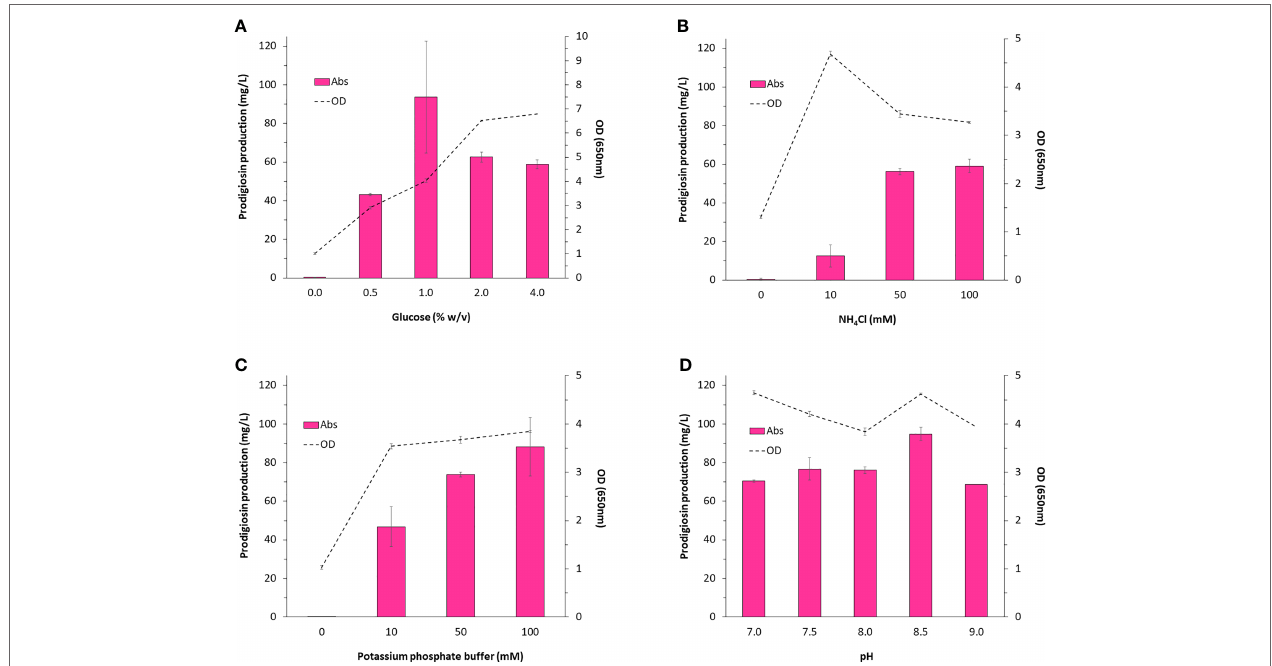
FIGURE 2 | Medium components impacting the production of prodigiosin in V. gazogenes PB1. V. gazogenes PB1 was cultivated in minimal media at 28°C in the presence of (A) 0 - 4% (w/v) glucose, (B) 0 - 100 mM ammonium chloride, (C) 0 - 100 mM phosphate buffer (pH 7.5), and (D) 100 mM phosphate buffer adjusted from pH of 7 to